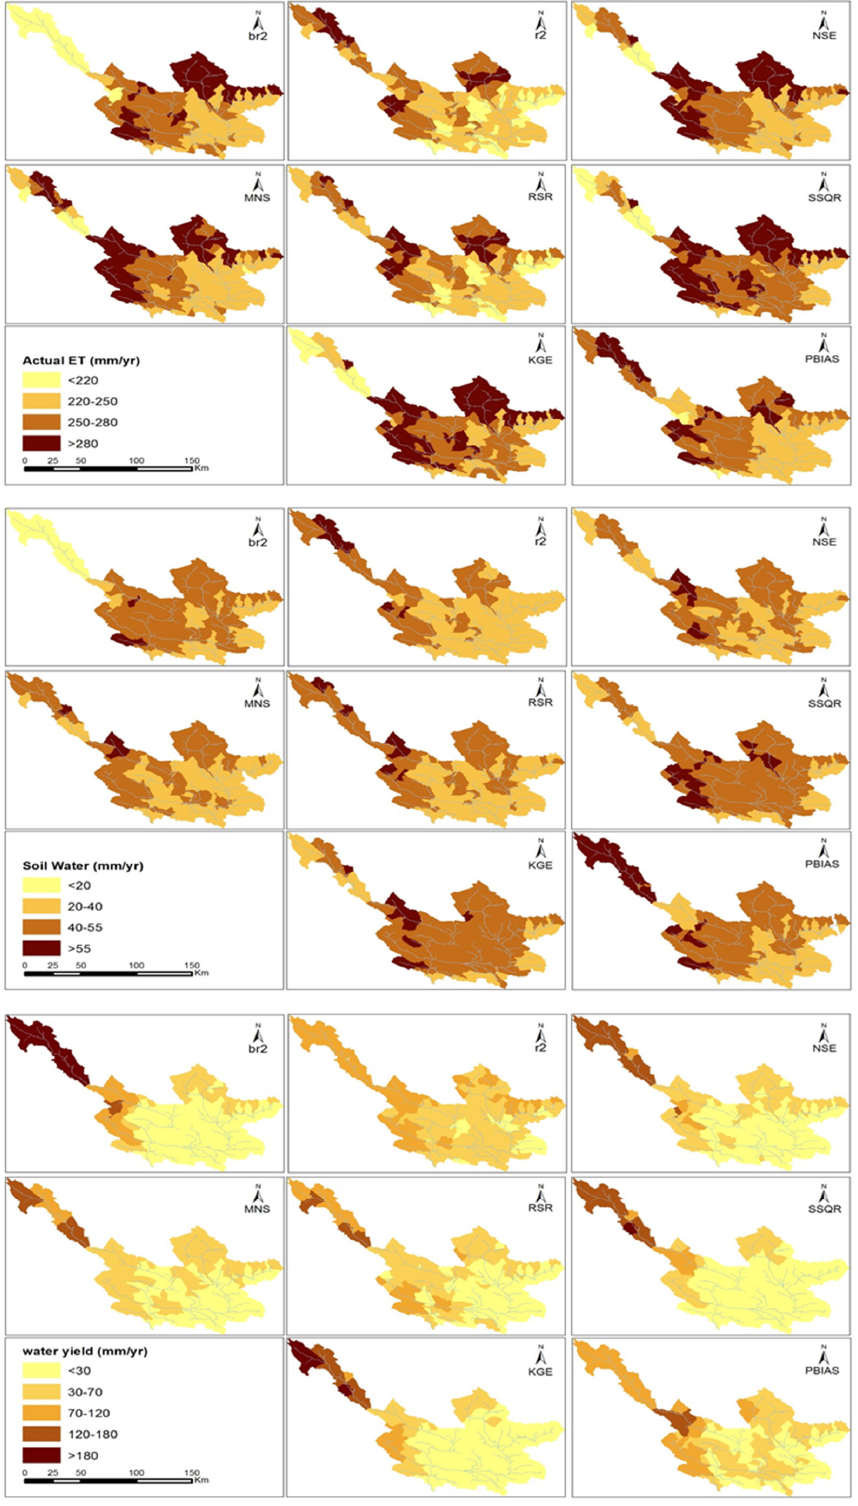
Figure 5. Distribution of annual average (top) actual evapotranspiration (mm·year − 1 ), (middle) soil water (mm·year − 1 ), and water yield (mm·year − 1 ) modeled by SWAT using different objective functions in calibration in Salman Dam Basin (SDB).